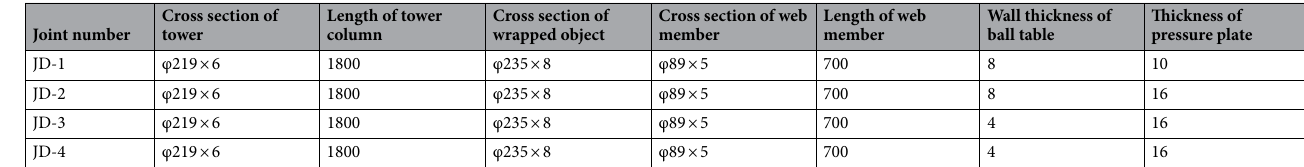
Table 4. Geometric parameters of components ( / mm).